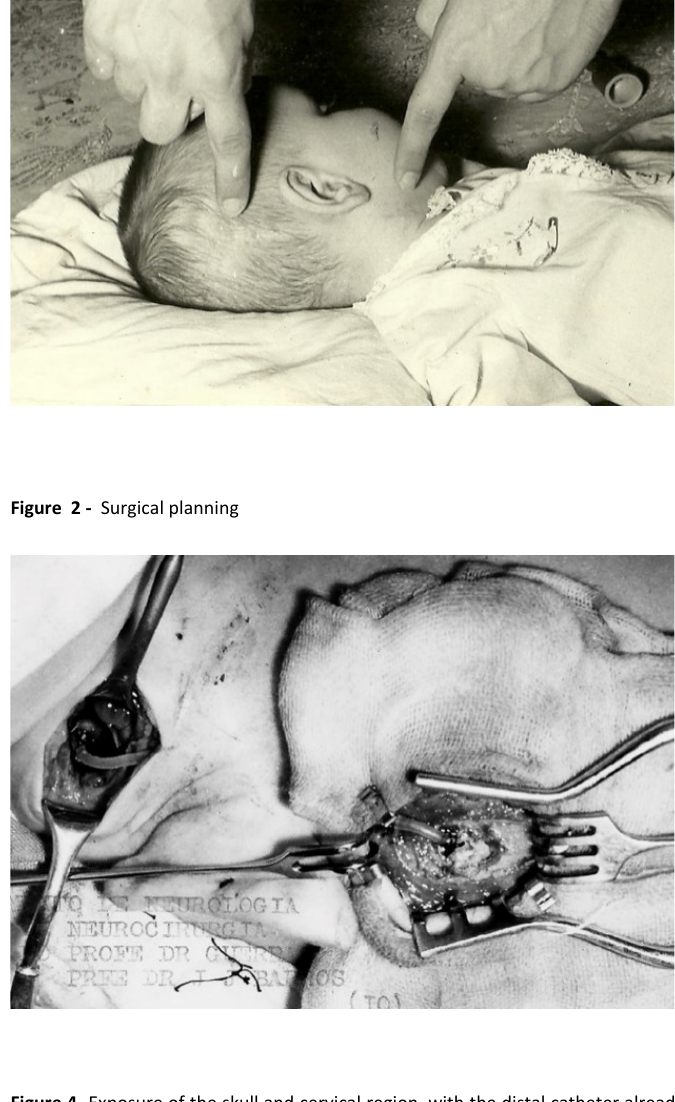
Figure 4 - Exposure of the skull and cervical region, with the distal catheter already